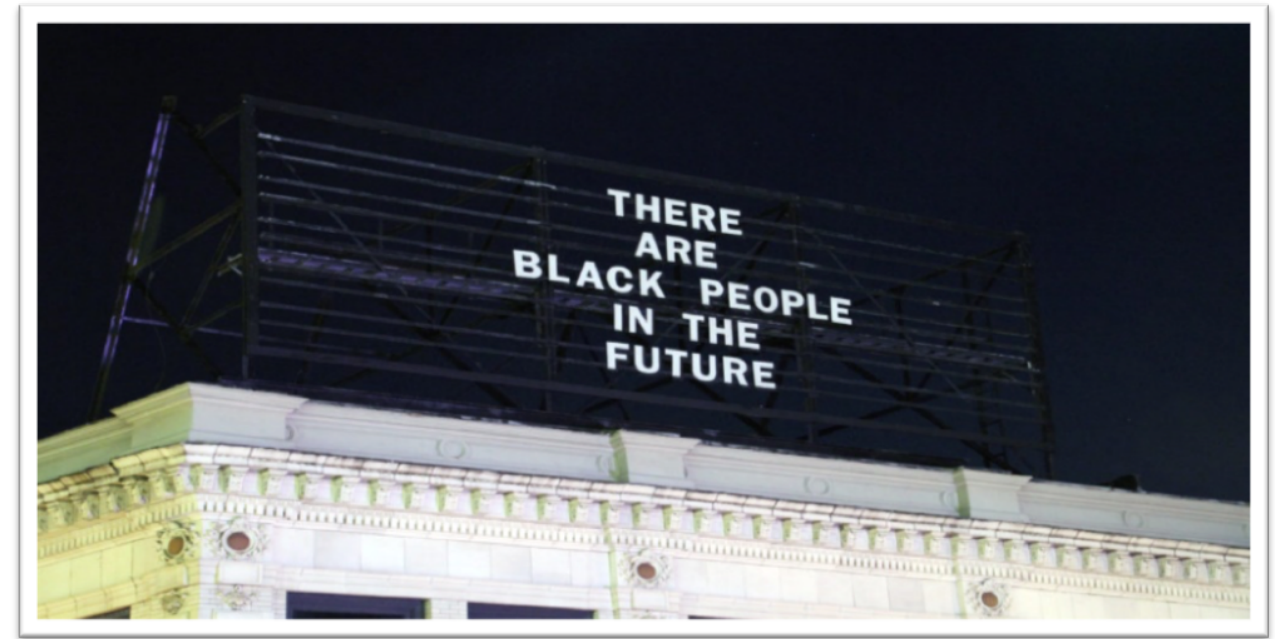
IMAGE: COURTESY OF THE ARTIST, ALISHA B.